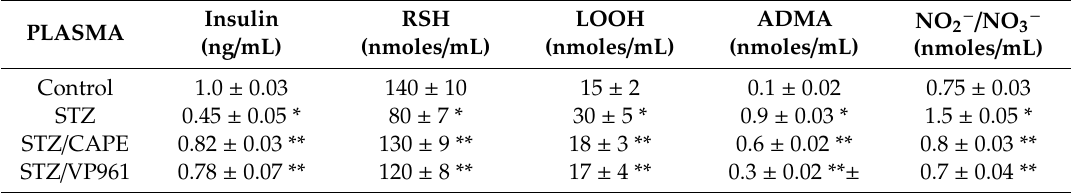
Table 2. Plasmatic insulin, non-proteic thiol groups, lipid hydroperoxide, Asymmetric NG, NG-dimethyl- l -arginine (RSH, LOOH, ADMA), and NO 2 − / NO 3 − levels. Insulin RSH LOOH ADMA PLASMA (ng / mL) (nmoles / mL) (nmoles / mL) (nmoles / mL) (nmoles / mL) Control 1.0 ± 0.03